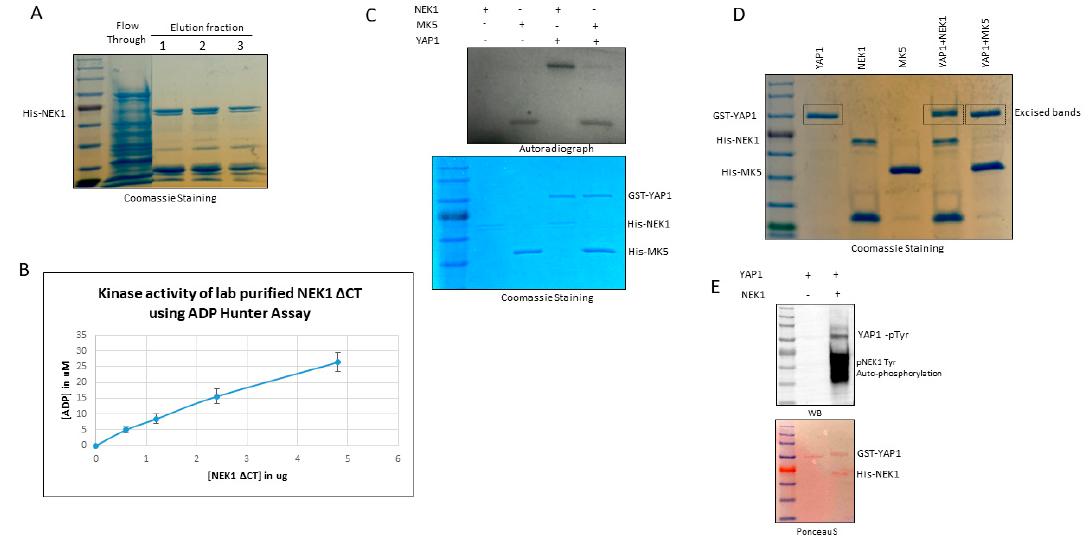
Figure 3. ( A ) Expression and purification of His-NEK1 kinase domain (NEK1 ∆ CT). ( B ) NEK1 ∆ CT was catalytically active and ATP / ADP conversion (kinase activity) was linear with the enzyme amount. ( C ) In vitro phosphorylation reactions of YAP using His-NEK1 and MK5 kinases in presence of [ γ - 32 P] ATP. ( D ) In vitro phosphorylation of YAP using His-NEK1 and MK5 kinases for preparative isolation for MS determination of phosphopeptides. ( E ) His-NEK1 also phosphorylated YAP on Tyr, as demonstrated by immunoreactivity with pY antibody.